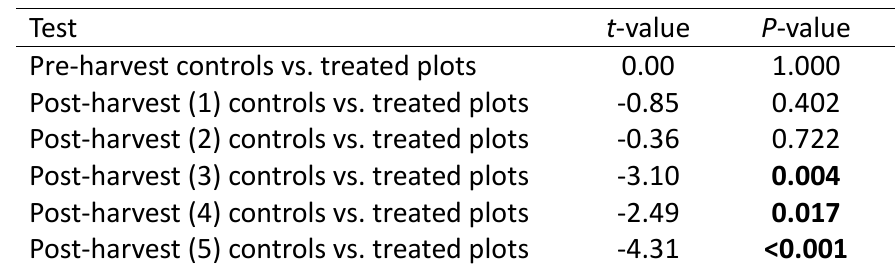
Table A1.6 . Year-specific treatment effects on density of Chestnut-sided Warbler, according to multiple comparison analyses (DF = 40).